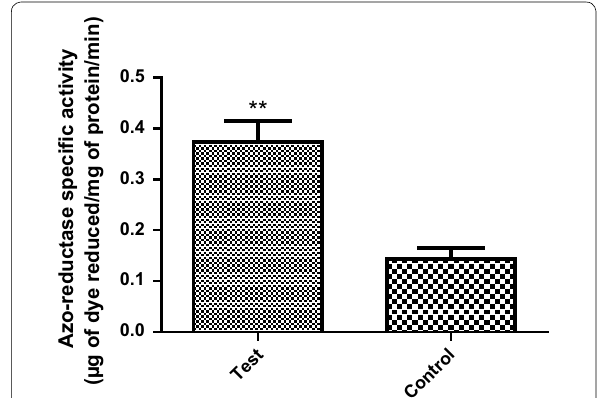
Fig. 2 Specific azo-reductase activity of isolate B1 when the cells were grown in the presence of the dye (test) as opposed to those grown in absence of the dye (control). The data represent means of triplicate experiments S.E. Decolorization by test cells is significantly ± different than by control cells at P < 0.01 (two-tailed